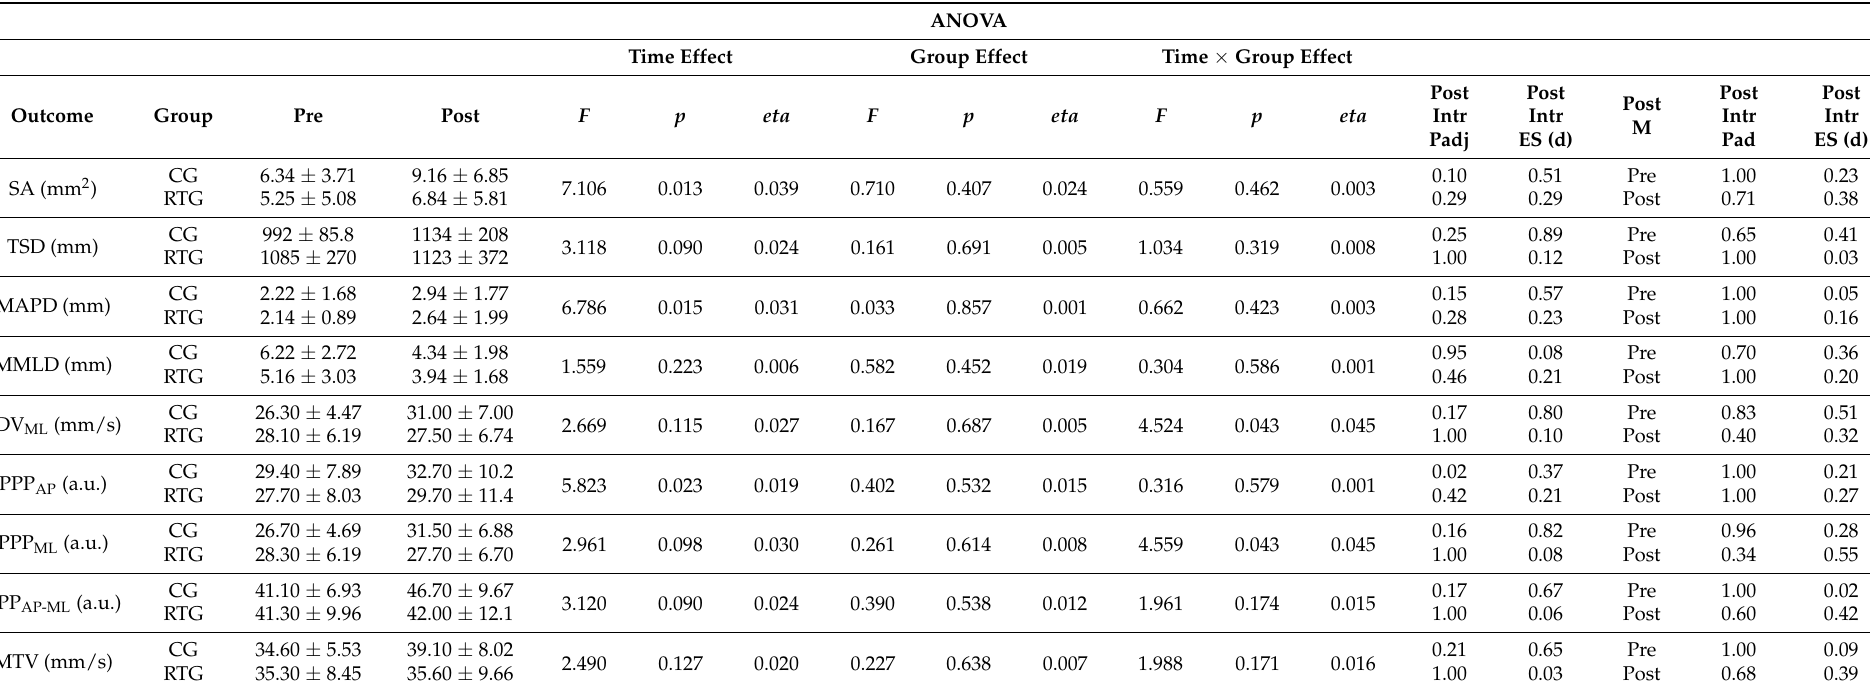
Table 7. Eyes-closed balance